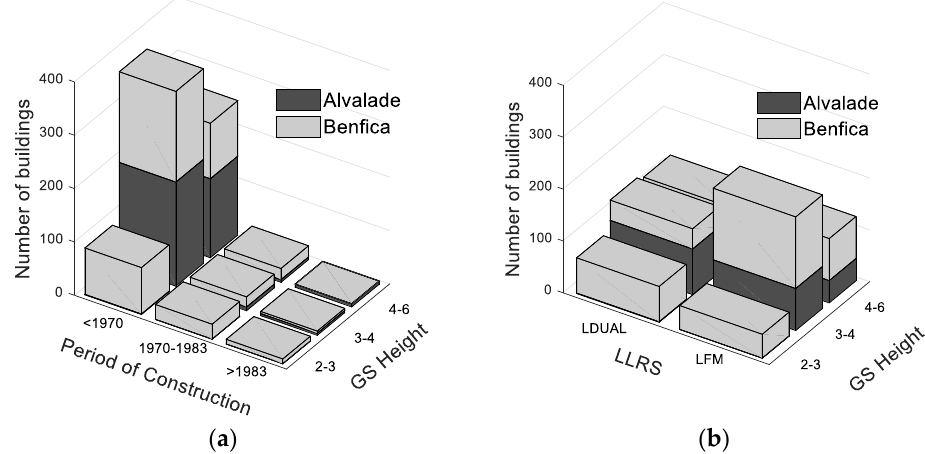
Figure 8. Distribution of buildings in function of the ground-storey (GS) height, in meters, and ( a ) period of construction and ( b ) lateral load resisting system.